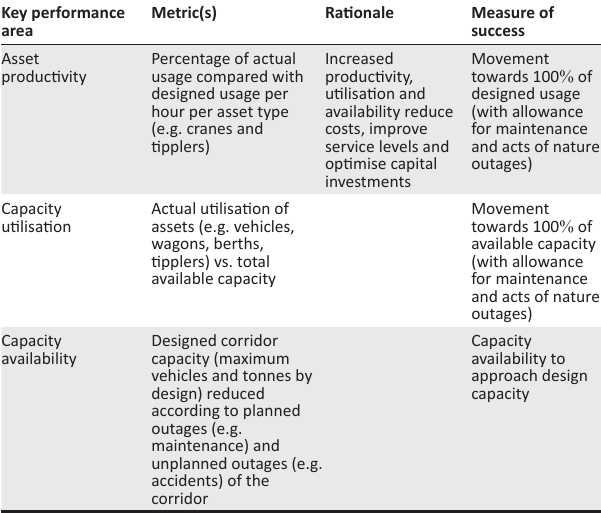
TABLE 5: Bulk export and multi-modal corridors – infrastructure perspective key performance areas. Key performance area